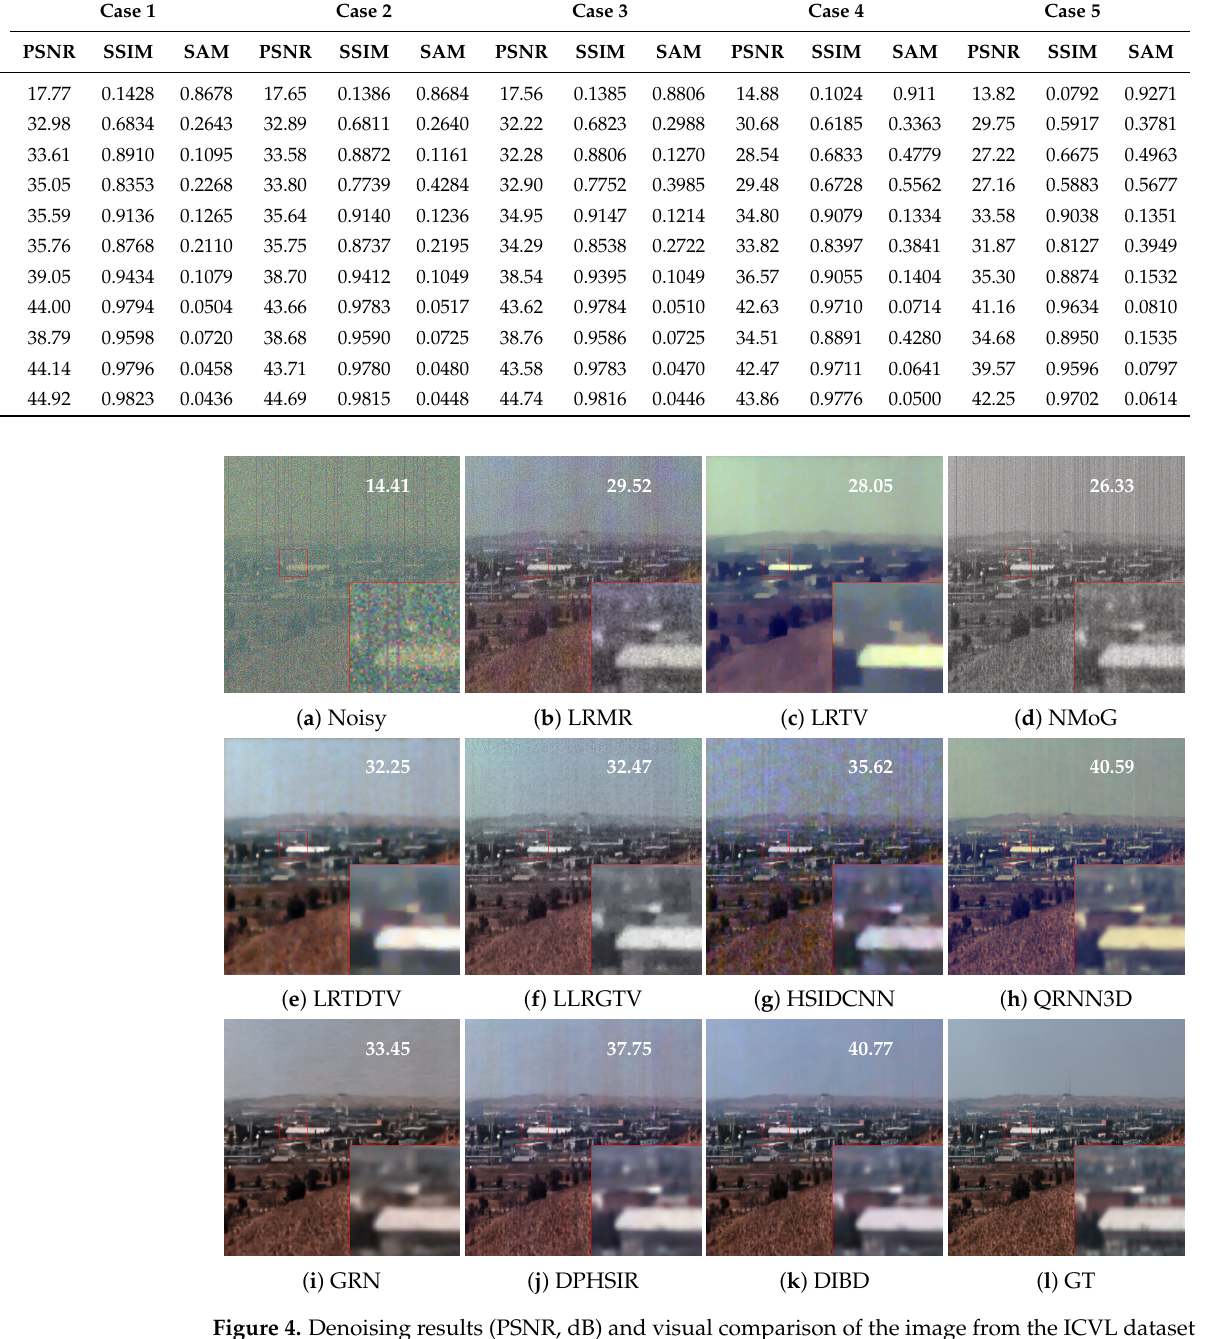
Figure 4. Denoising results (PSNR, dB) and visual comparison of the image from the ICVL dataset under the complex case 5. The RGB image is synthesized by HSI bands 21, 11,